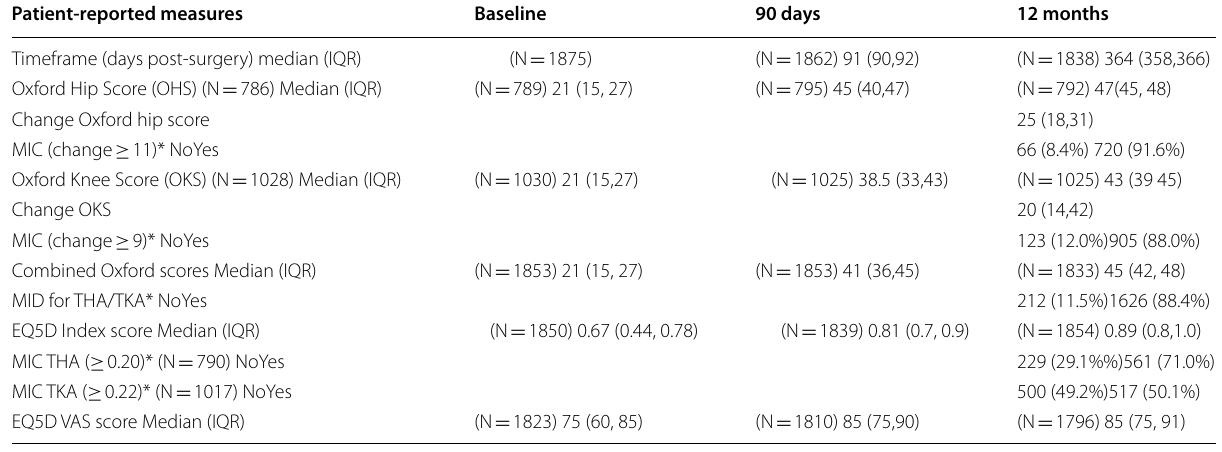
Table 2 Patient‑reported outcomes (N